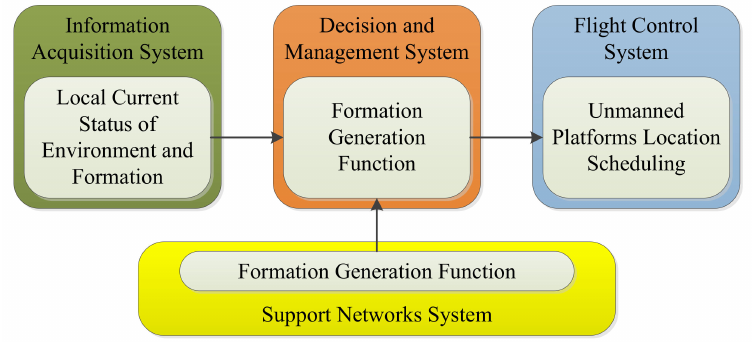
Figure 2. Input and output of the formation generation